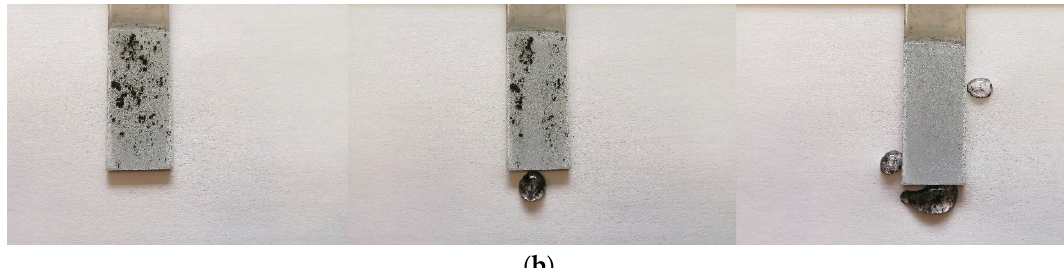
Figure 11 . Durability of the as-prepared coating is showed by ( a ) WCA remains slightly constant and higher to 150° after each sandpaper abrasive cycle while SA increases until a maximum value of 6°; and ( b ) self-cleaning properties were investigated after abrasive paper test.